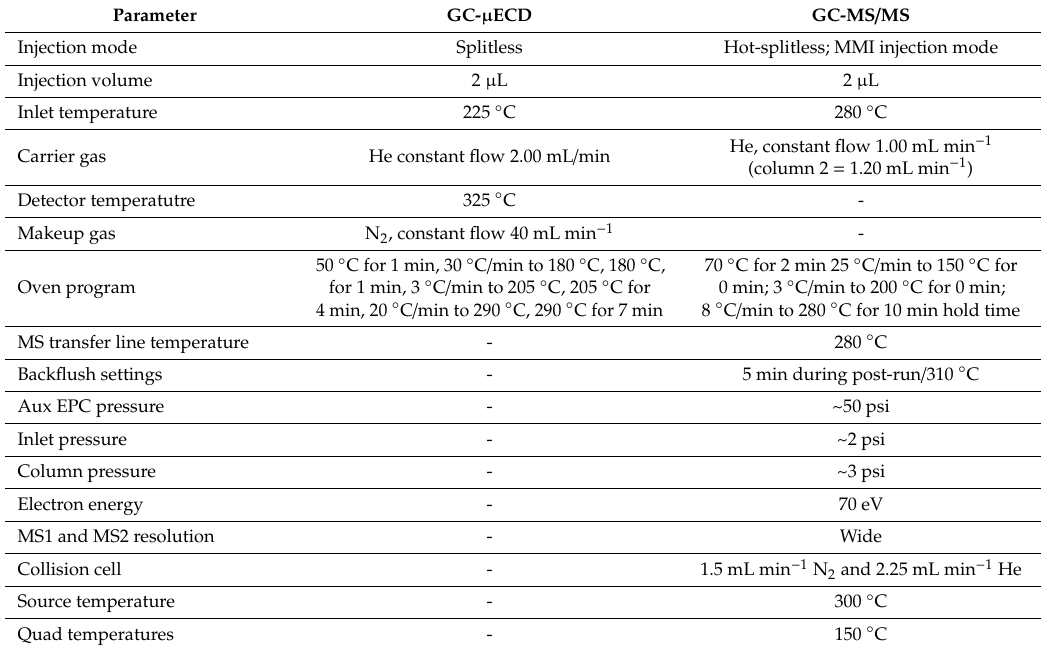
Table4. Gaschromatographywithanelectroncapturedetector(GC- µ ECD)anddualmass-spectrometry (GC-MS / MS) method